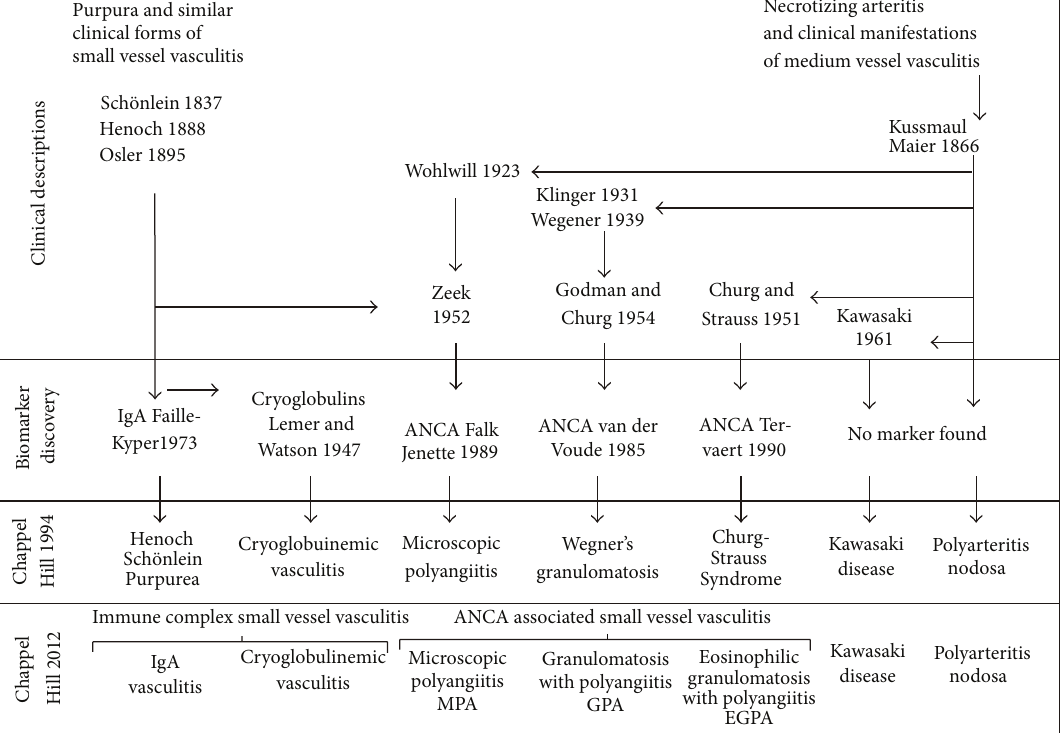
Figure 2: Disease nomenclature system adopted by the 2012 International Chapel Hill Consensus Conference